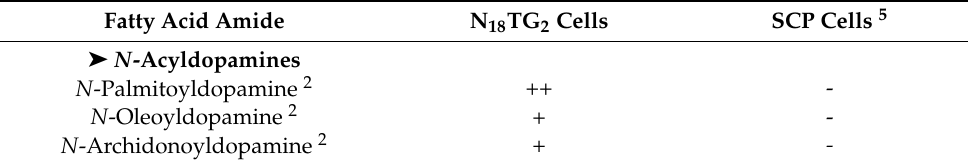
Table 1. Cont. Fatty Acid Amide N 18 TG 2 Cells SCP Cells 5 (cid:228) N